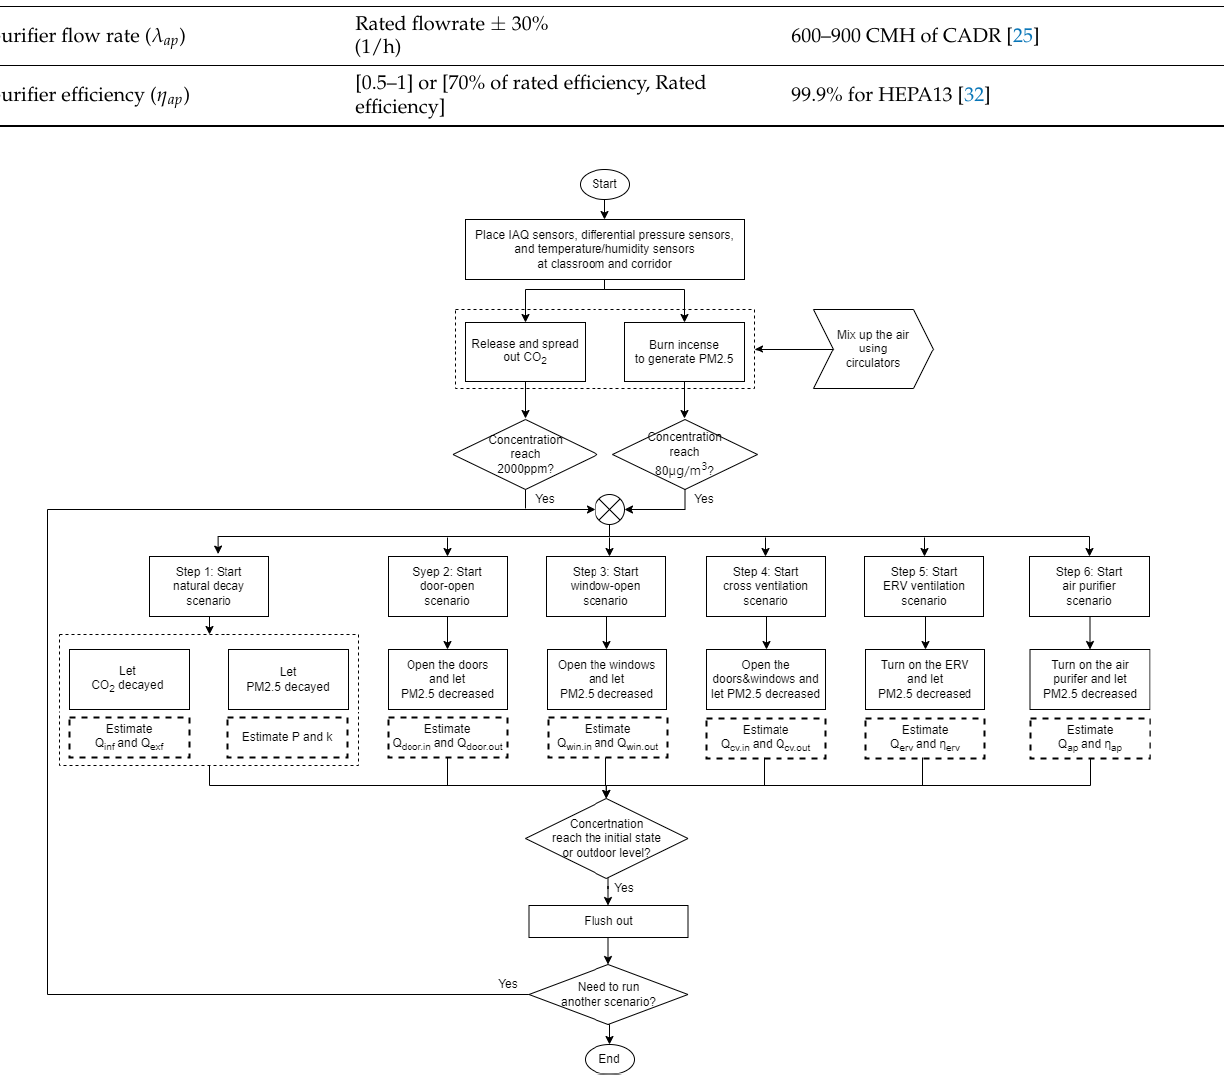
Figure 3. Measurement protocol.